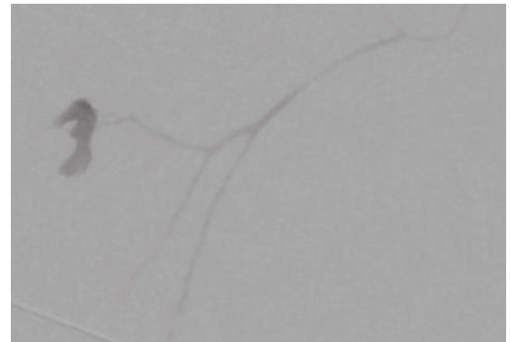
Figure 2: Angiography demonstrating blush in the left superior thyroid artery, raising concerns for an active hemorrhage into the